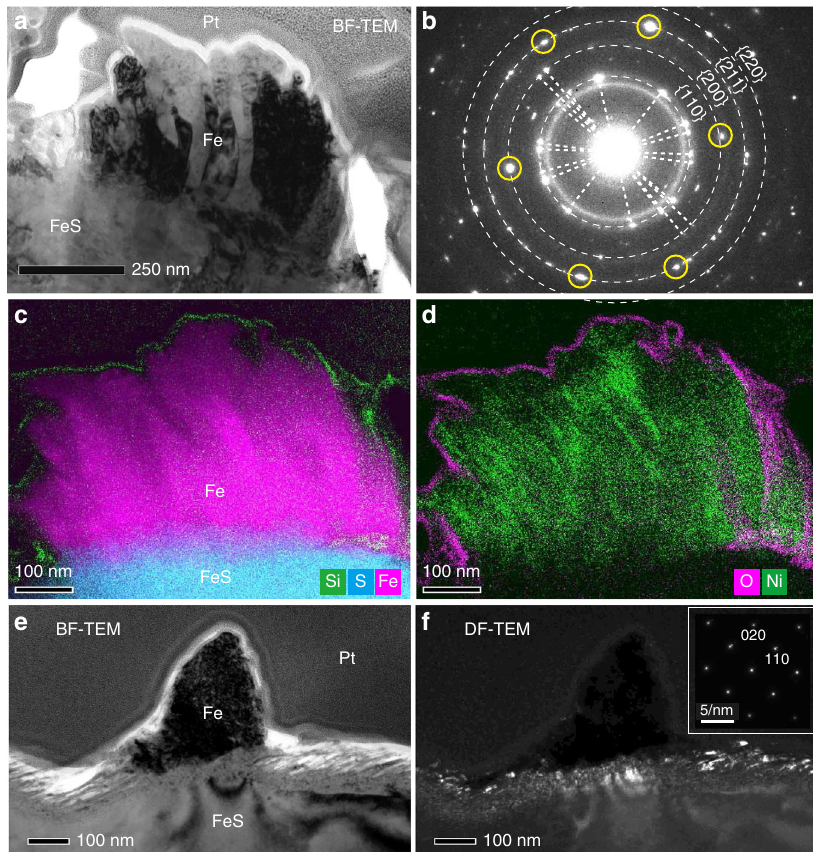
Fig. 2 Detailed structures of metallic iron whiskers on troilite. a A TEM bright- fi eld (BF) image of a whisker on troilite in a FIB section. b A SAED pattern of the whole region of the whisker. Dotted rings have radii corresponding to the d-spacings of {hkl}planes of bcc iron. Pairs of diffraction spots from the same crystals are connected by dotted lines. The six circled spots are re fl ected from a single iron crystal belonging to a zone axis [1 ̅ 20]. c-d X-ray intensity maps of the whisker in ( a ). Composite image of Si (green), S (cyan), and Fe (magenta) is shown in ( c ) and that of O (magenta) and Ni (green) is displayed in ( d ). e A TEM-BF image of a thinner whisker in a FIB section from an edge-on view (the electron beam was nearly parallel to the troilite surface). f A TEM-dark fi eld (DF) image corresponding to ( e ). A SAED pattern obtained from the whisker is shown on the upper right, showing bcc iron in zone axis [001]. a-d was obtained from FIB section RA-QD02-0292-01 (Supplementary Fig. 2). e-f was obtained from FIB section RA-QD02-0325-01 (Supplementary Fig.